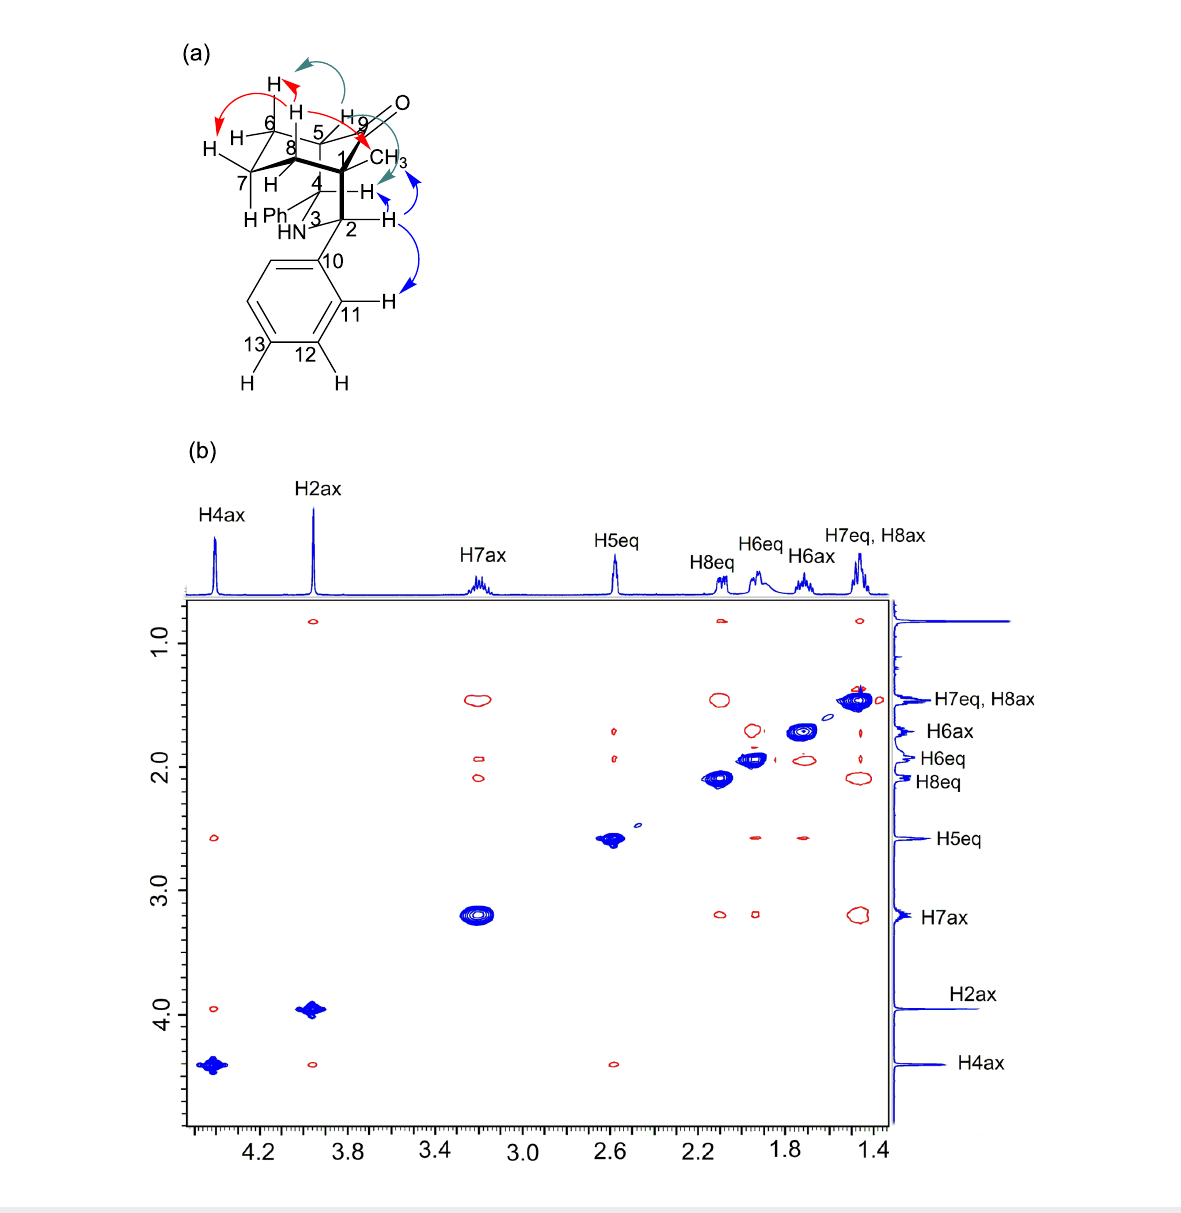
Crystals of 6 were obtained by slow evaporation of a saturated acetone solution. The molecule crystallized in a triclinic crystal lattice with the P − 1 space group. Crystals of 7 were obtained by slow evaporation of a saturated toluene solution. Compound 7 crystallized in an orthorhombic crystal lattice with the non- centrosymmetric space group Pna 2 1 . Hence, the molecule exhibits optical activity (Figure